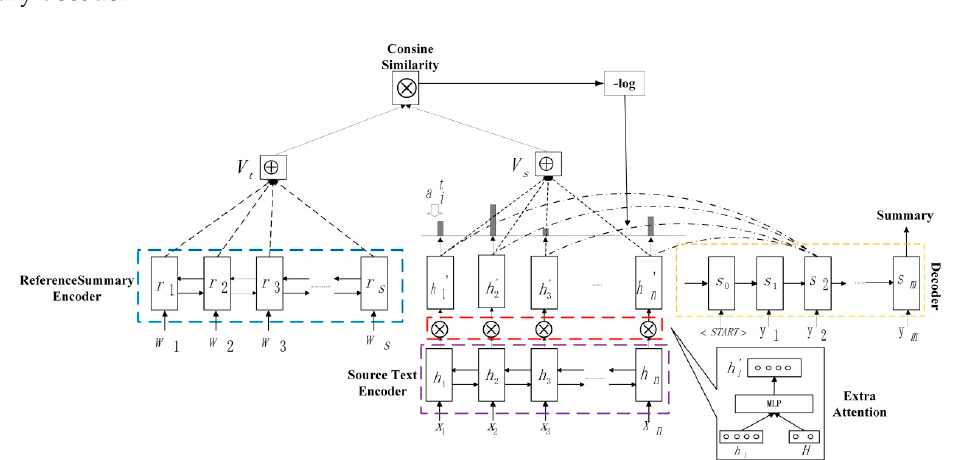
Figure 3. Our proposed model. Before the decoder, an extra attention mechanism is used to extract important information and compare the similarity of the reference summary and the extracted information to ensure the correctness of the necessary information. In order to enhance the ability of the extra attention mechanism in extracting information, the similarity score is fed back to the network, skipping the decoder.